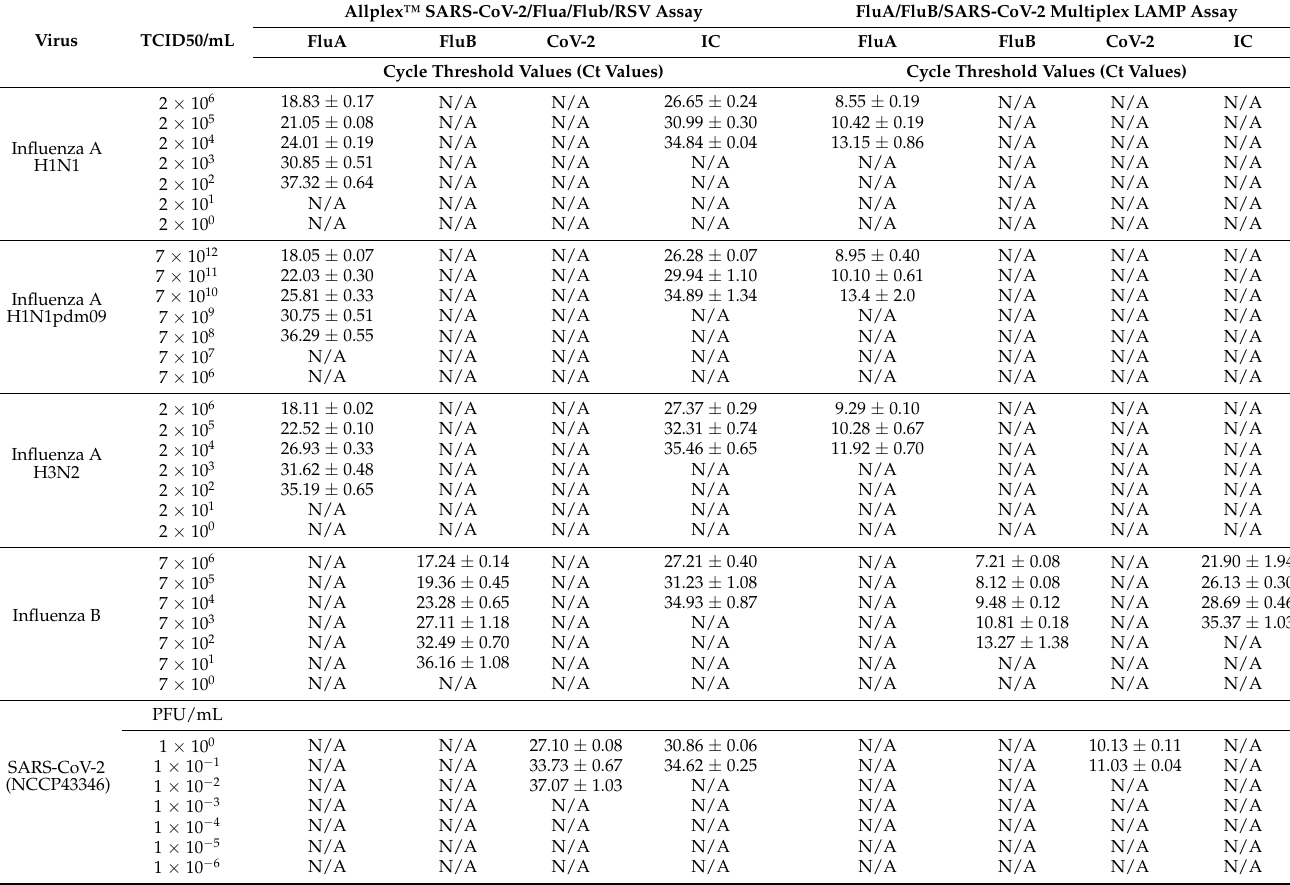
Table 4. Limit of detection test for Allplex™ SARS-CoV-2/FluA/FluB/RSV and FluA/FluB/SARS- CoV-2 multiplex LAMP assays for influenza A H1N1, H1N1pdm09, H3N2, influenza B, and SARS- CoV-2 RNA